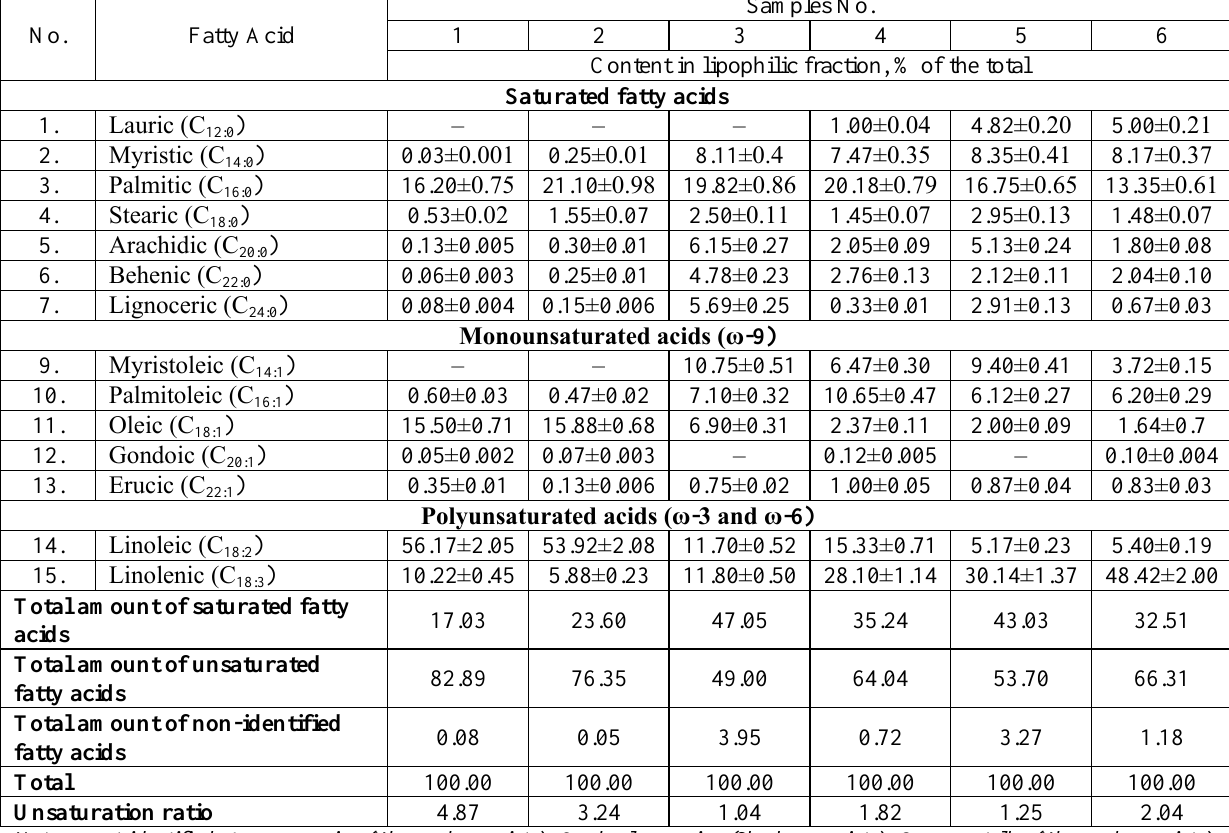
Fig. 6. Gas chromatogram of fatty acid composition in a lipophilic fraction of barley leaves (Shedevr variety) The analysis results of the fatty acid composition of lipophilic extracts of grains, stalks and leaves of rye (Khamarka variety) and barley (Shedevr